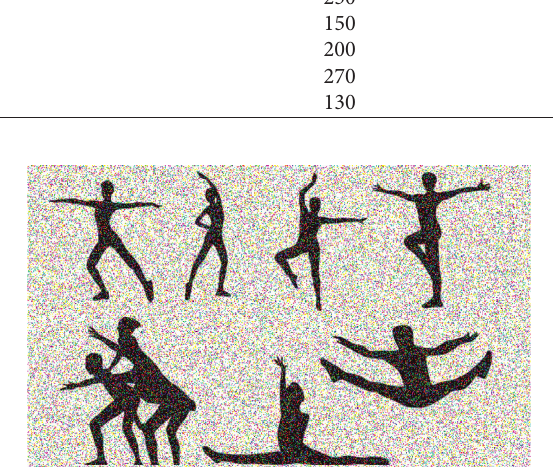
Figure 6: Original